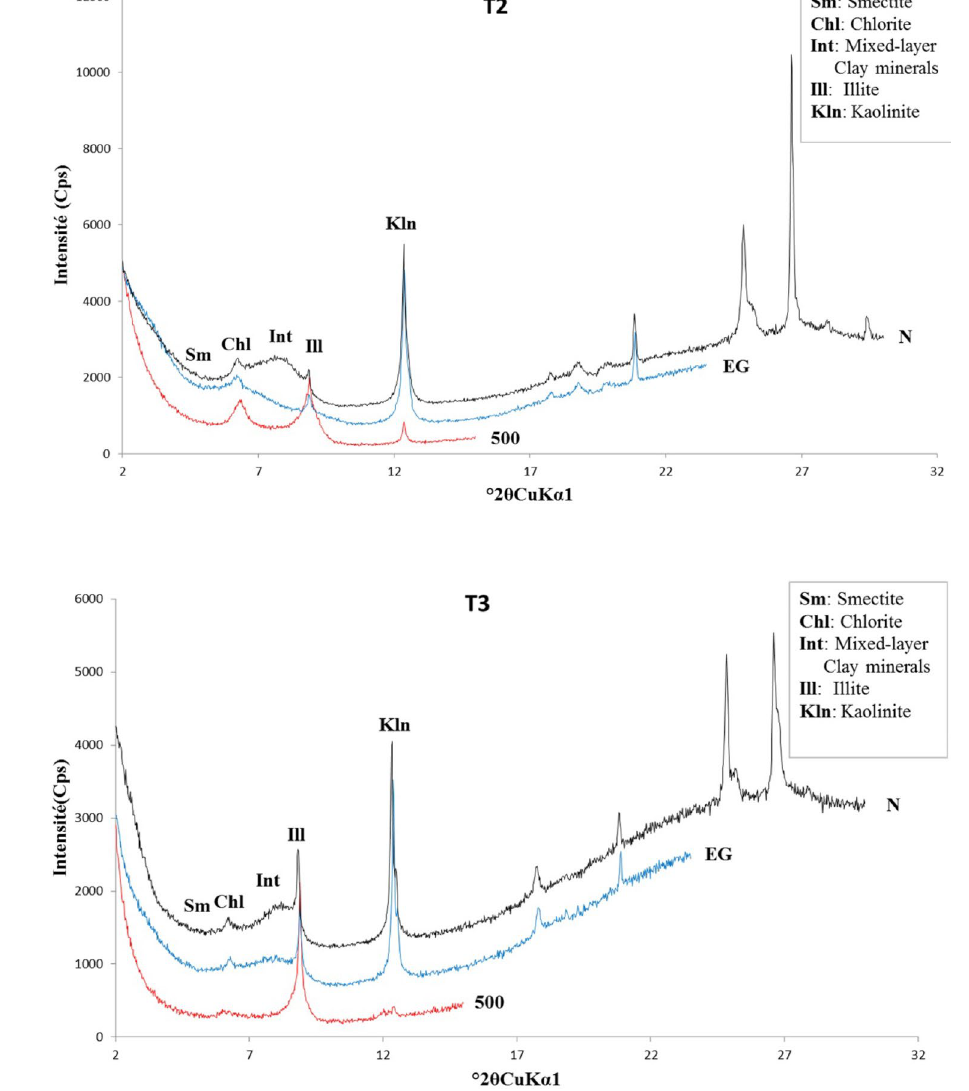
Fig. 5 X-ray diffraction pat- terns (N, EG, 500) for oriented preparations in < 2 µm clay fractions ( Sample: T2 )